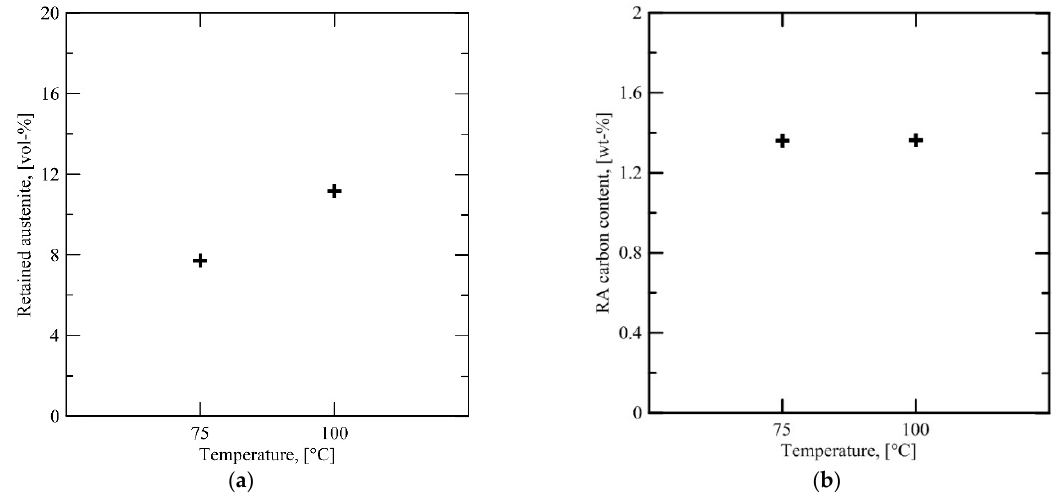
Figure 10. ( a ) The retained austenite fraction of Steel C with respect to initial quench temperature QT . ( b ) The carbon content of the retained austenite with respect to QT . Specimens annealed at 850 °C, quenched to QT and partitioned at 450 °C for 100 s.